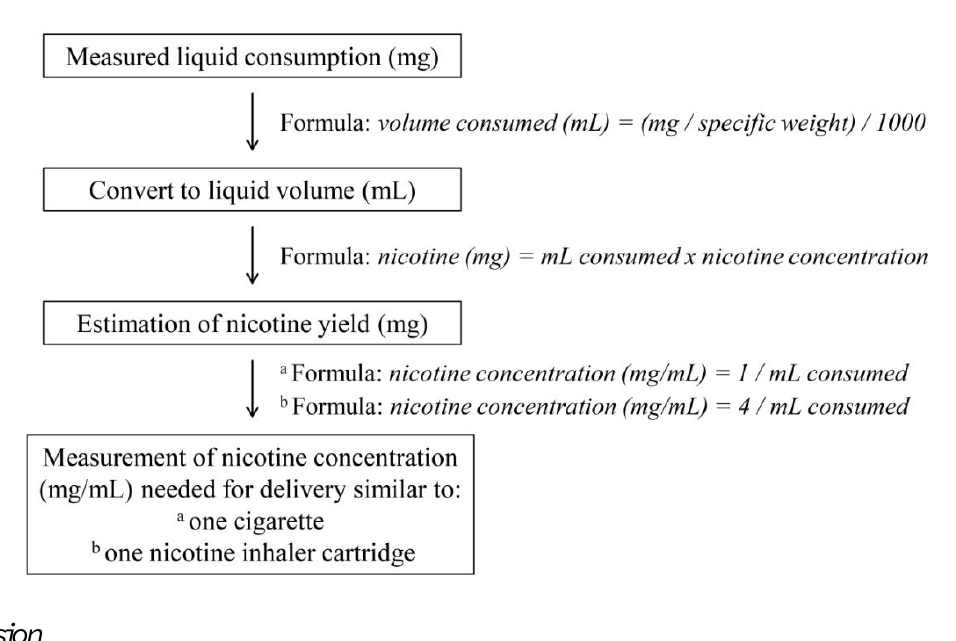
Figure 3. Schematic of the methodology used to estimate nicotine concentration of EC liquid needed to deliver nicotine amount similar to one tobacco cigarette and one nicotine inhaler